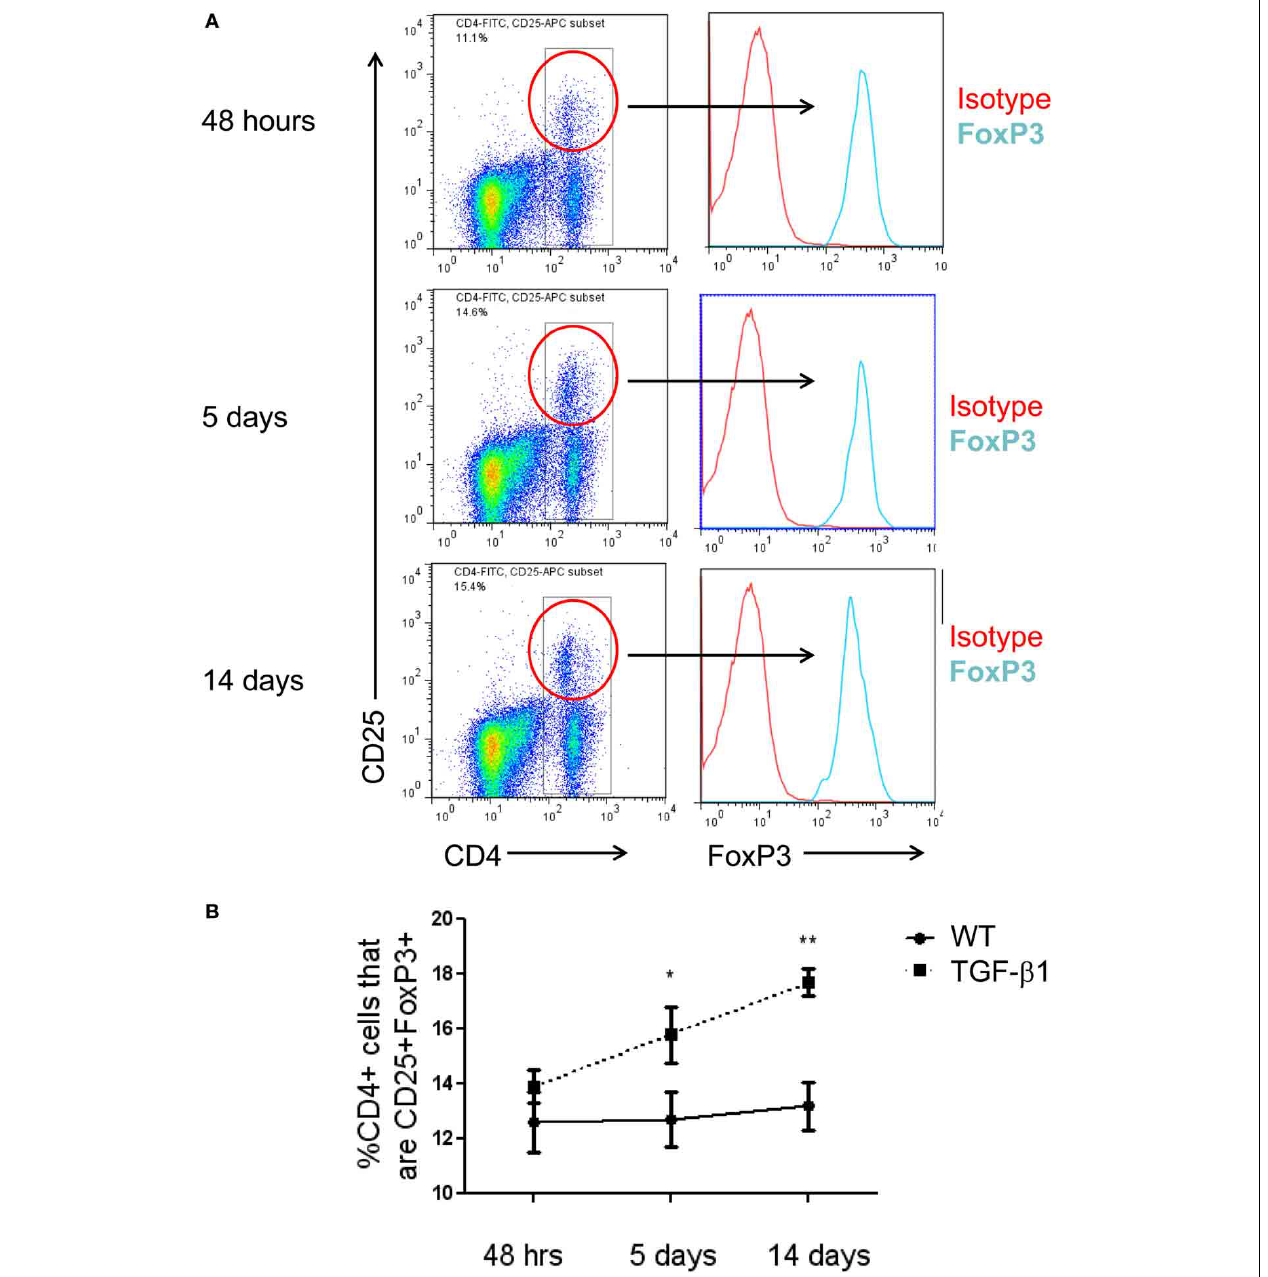
FIGURE 1 | CD4 + CD25 + FoxP3 + Tregs accumulate in the TGF- β 1- exposed murine lung. (A) Flow cytometric detection of Tregs in the TGF- β 1 Tg + lung. TGF- β 1 Tg + and Tg − (not shown) mice were administered doxycycline in their drinking water for 2, 5, or 14 days, sacrificed, and flow cytometry was performed on lung digests. Live cells were analyzed and percent of cells triple positive for CD4, CD25,